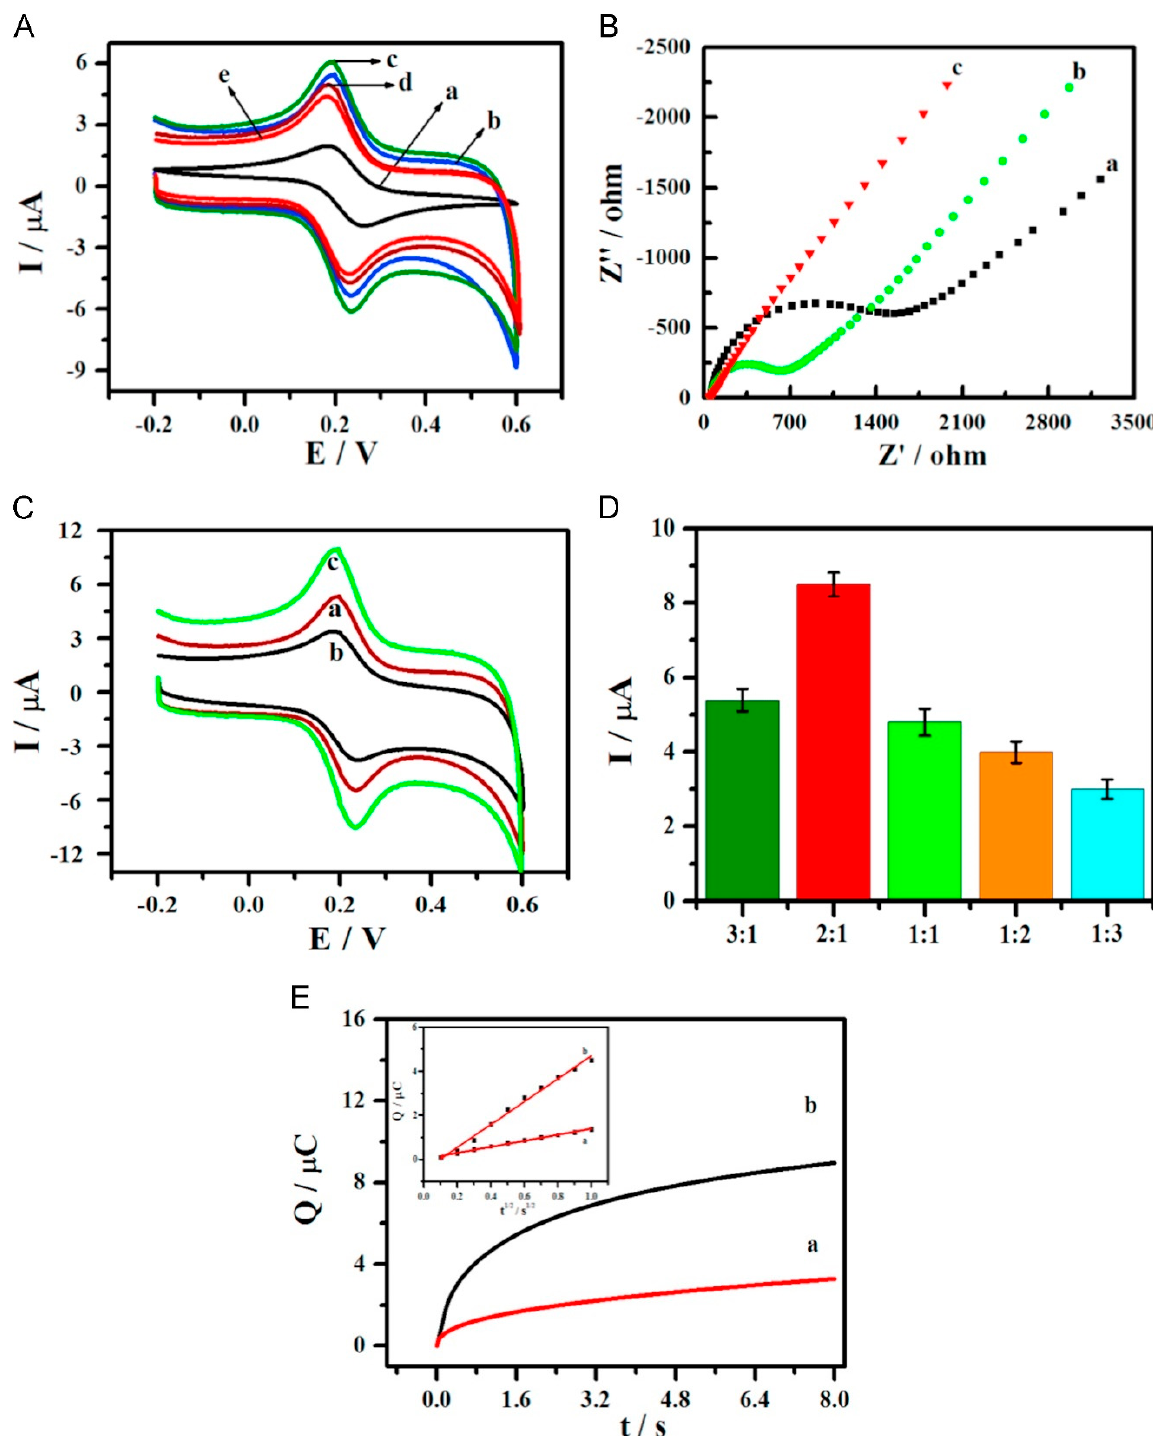
Figure 4. ( A ) CV of different electrodes at a scan rate of 50 mV s − 1 : (a) GCE, (b) MoS 2 /CA/GCE, (c) AuNPs/MoS 2 /CA/GCE, (d) Apt1/AuNPs/MoS 2 /CA/GCE, (e) BSA/Apt1/AuNPs/MoS 2 /CA/GCE; ( B ) Nyquist plots of bare GCE (a), MoS 2 /CA/GCE (b), AuNPs/MoS 2 /CA/GCE; ( C ) CV of BSA/Apt1/AuNPs/MoS 2 /CA/GCE (a), PGDF-BB/BSA/Apt1/AuNPs/MoS 2 /CA/GCE (b), Fc-AuNPs-Apt2/PGDF/BB/BSA/Apt1/AuNPs/MoS 2 /CA/GCE; ( D ) DPV response to the different volume proportions of AuNP-modified Fc (5 mM) and Apt 2 (1 μ M); ( E ) Plot of Q-t curves of the (a) GCE and (b) AuNPs/MoS 2 /CA/GCE. Inset plot of Q-t 1/2 curves on (a) GCE and (b) AuNPs/MoS 2